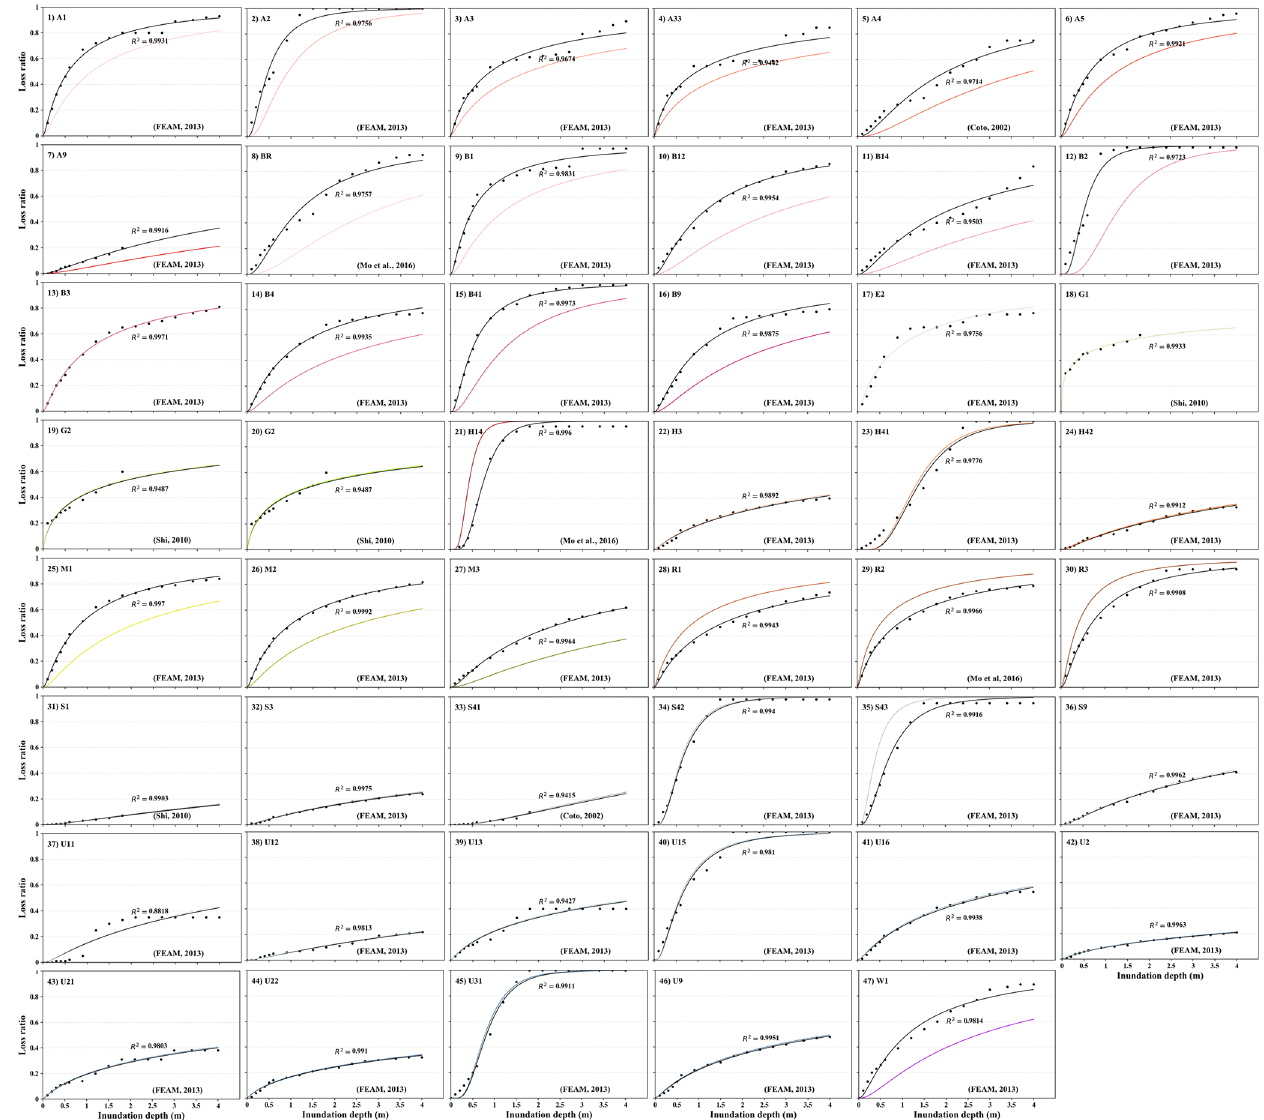
Figure 6. Fitting and optimization of vulnerability curves of land use in Liandu district (the black dots refer to the inundation depth and loss ratio based on the reference, the black curve is the fitting result of the black dots by the lognormal cumulative distribution function (CDF), and the color curve is the optimized result based on the disaster loss